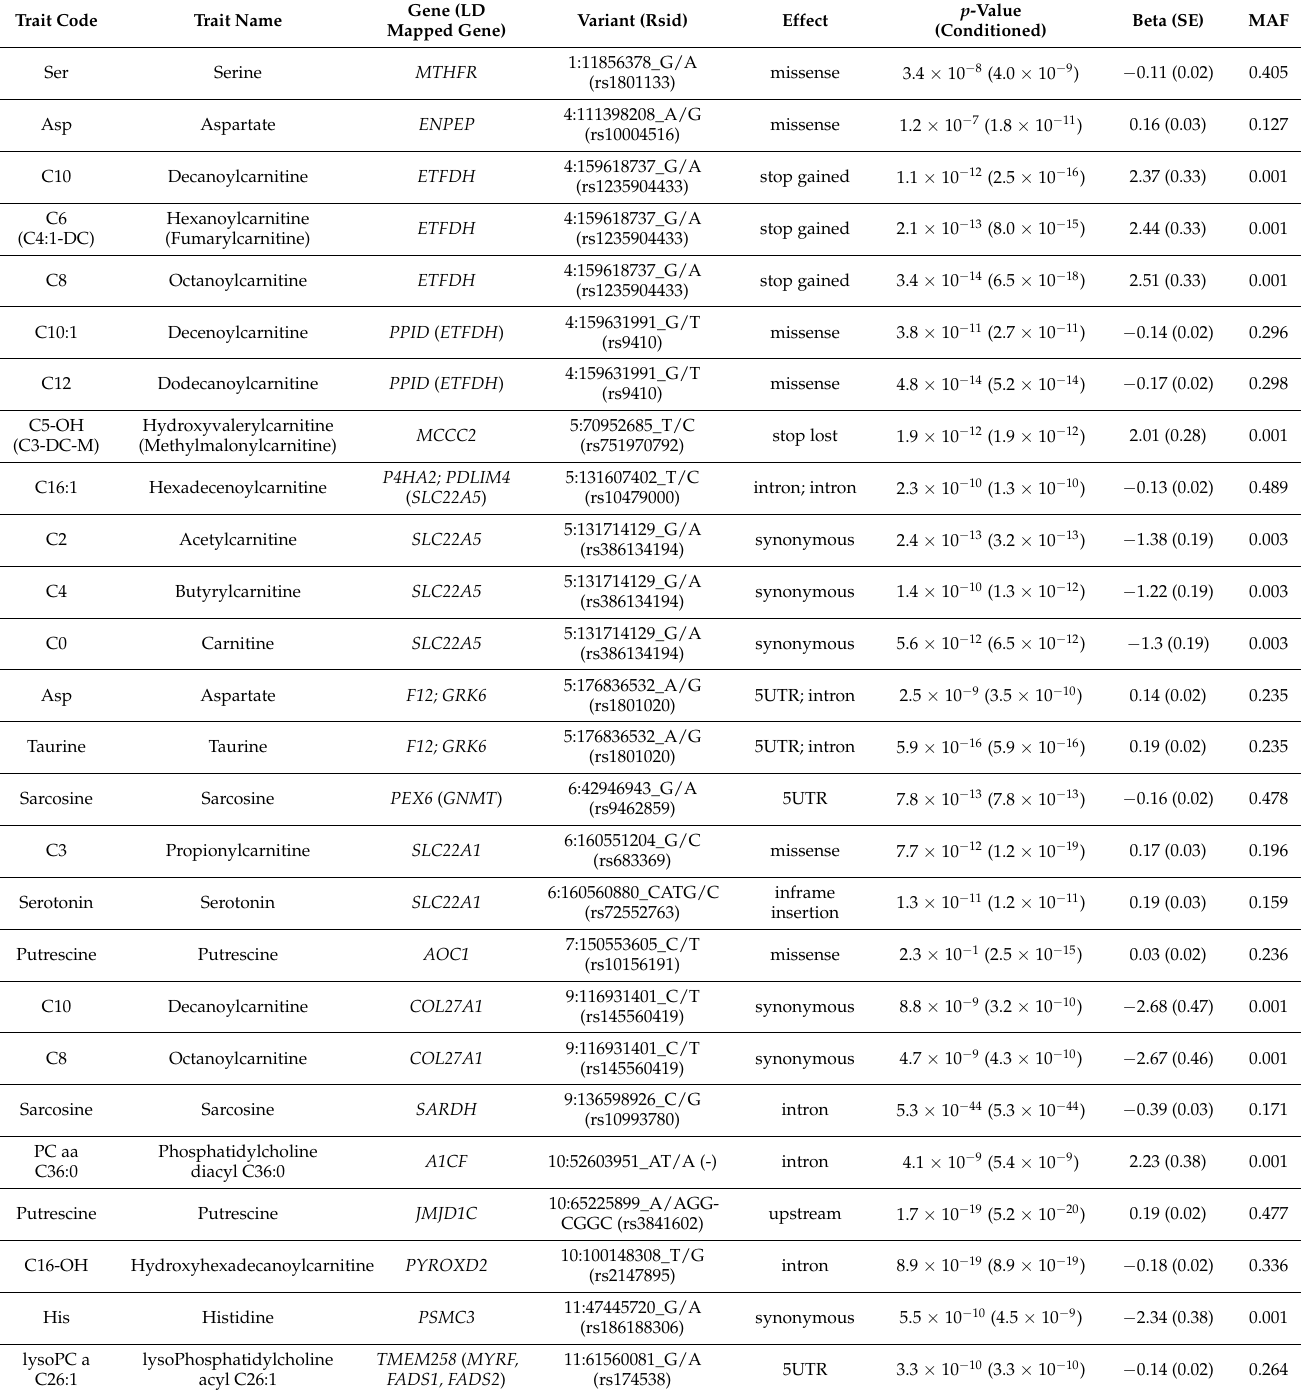
Table 1. Locus-trait associations conditionally significant at a 5.5 × 10 − 9 threshold in the WES combined